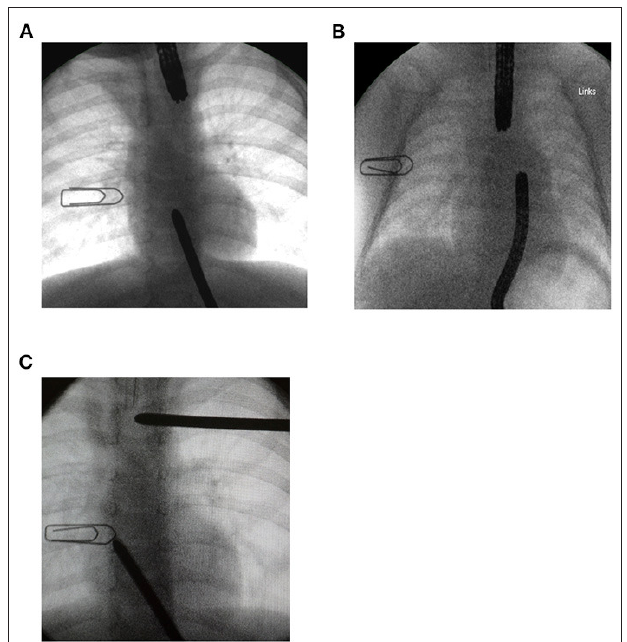
FIGURE 1 | Radiographic gap assessment at 3 months of age. A 1cm wide paperclip was placed on the patient’s chest as a reference to measure gap length. (A) A flexible endoscope was placed in the upper pouch while a Hegar dilator marked the lower pouch. (B) Flexible endoscopes placed in each pouch. (C) One Hegar dilator placed at the site of spit fistula while the tip of the second dilator marked the upper end of the lower pouch.